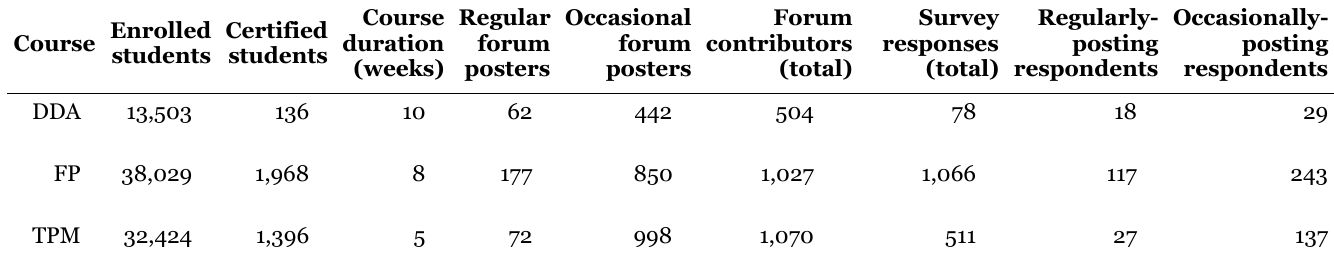
Table 1 Data Description: Summary of the